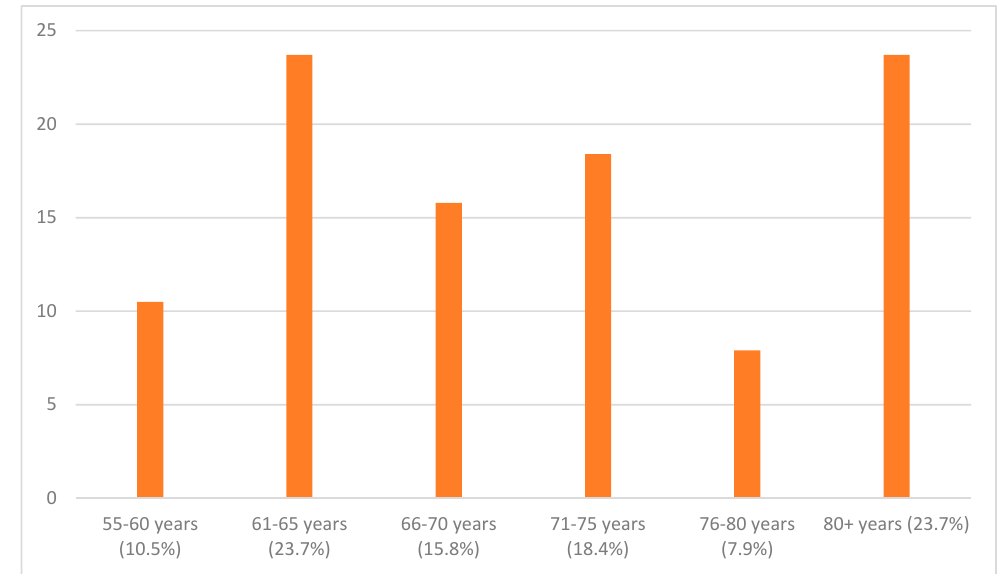
Figure 2. Age distribution of the elderly control population.